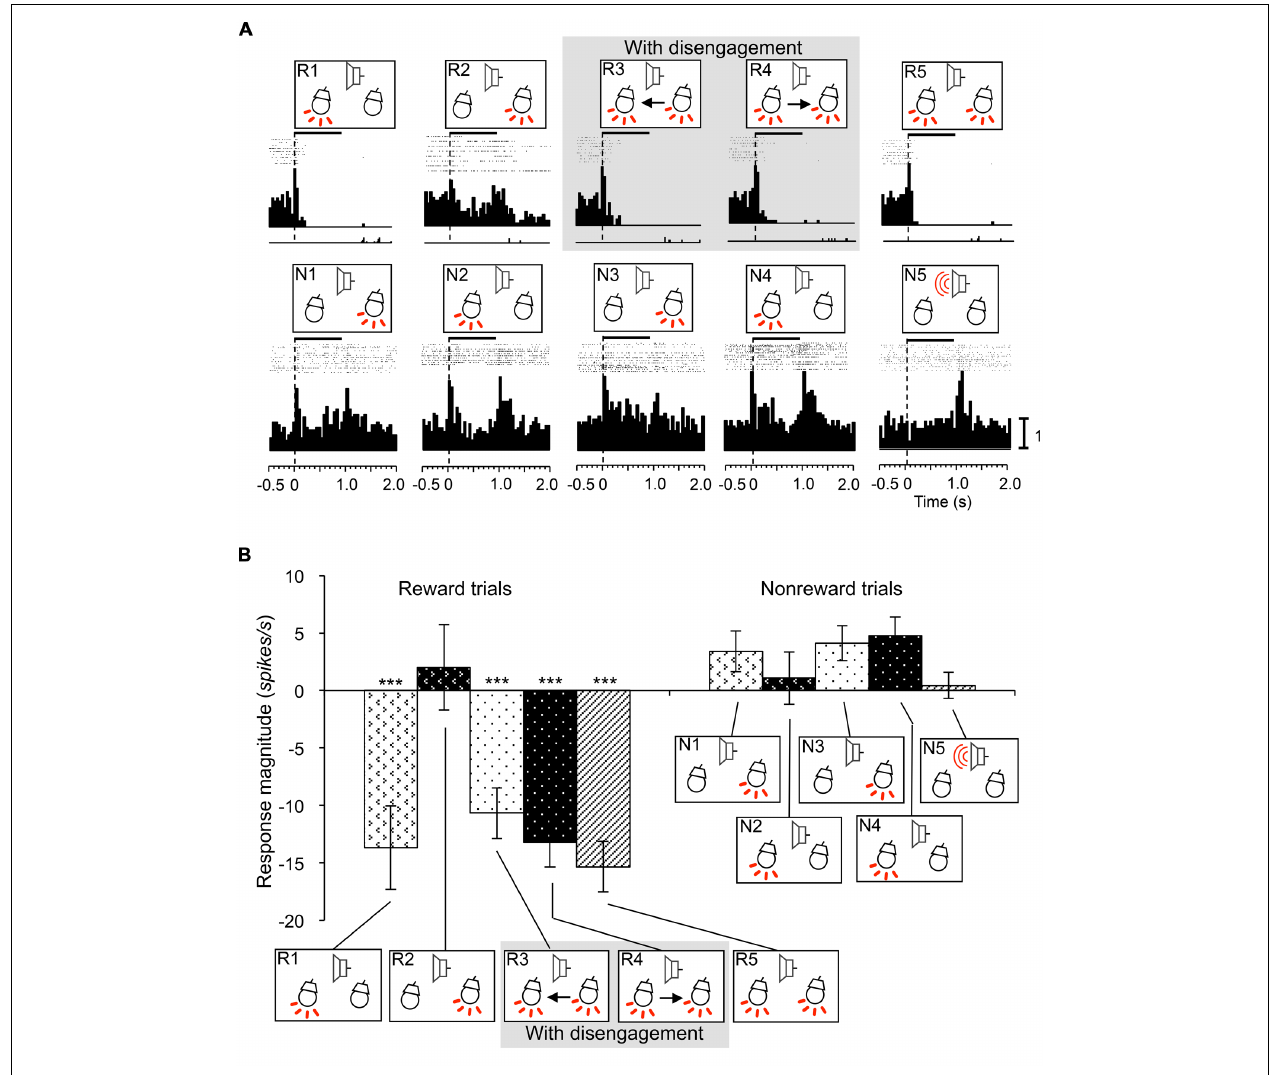
FIGURE 8 |An example of an inhibitory responsive neuron recorded from the right SC. (A) Raster displays of neuronal activity and summed histograms in response to each stimulus.The neuron showed inhibitory responses to the all CSs that included left light in the reward trials.